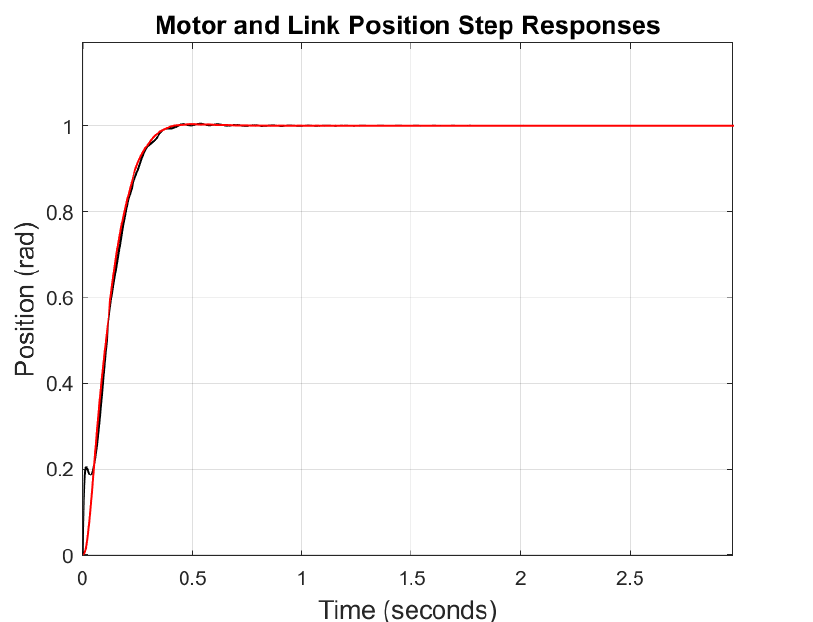
Figure 16. Motor and Link position time responses with variation in the link inertia—Black line: Motor Response; Red line: Link